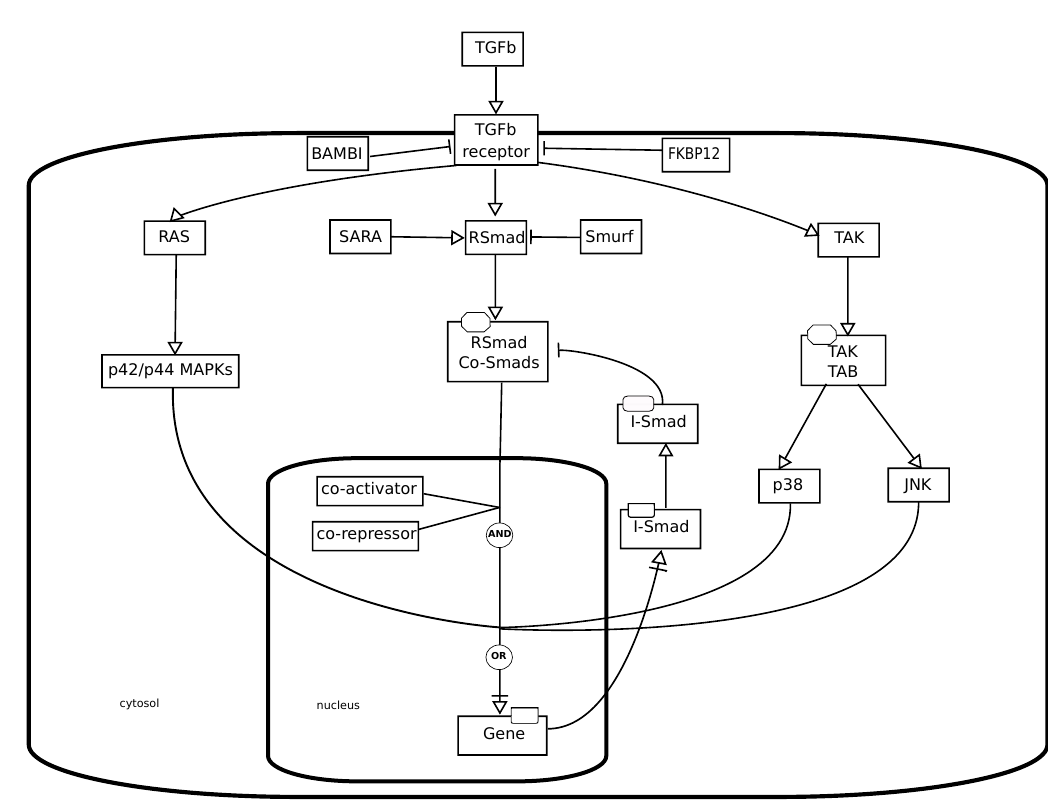
Figure A.3: Transforming Growth Factor beta signaling